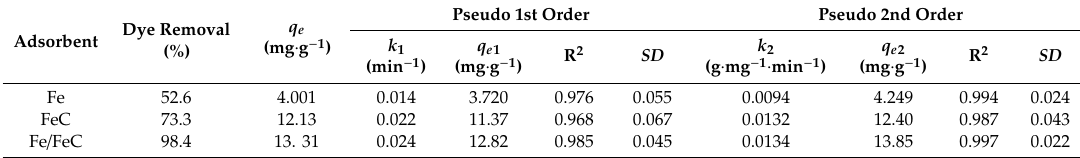
Table 6. Kinetic parameters at 25 o C for Acid Red 66 adsorption on the solids.